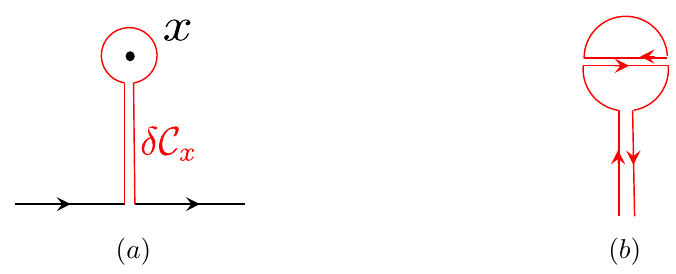
Figure 6 . ( a ) Deformation of the contour (cid:14) C x denoted in red. We pick a point x close to the Wilson loop, draw a small circle and connect it to the original contour. ( b ) One-loop correction to h Sym i coming from the gluon exchange. Here we used the double-line notation to make manifest the contraction of